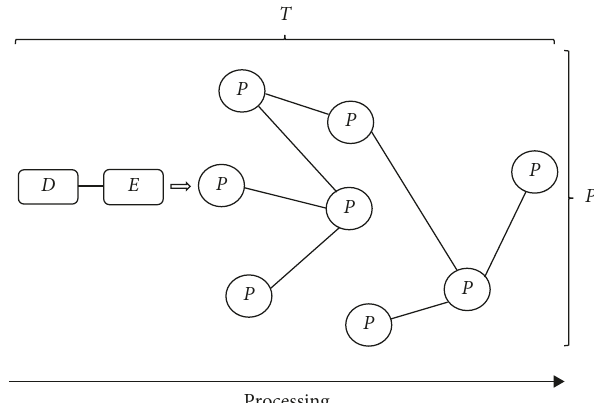
Figure 4: Ergodic representation of a demand and execution of work that results in a precision ( P ), which in turn interacts with other demands and executions that can maintain a chain or web of interrelated events (mutual information), dependent on process- ing, time, and accuracy factors.